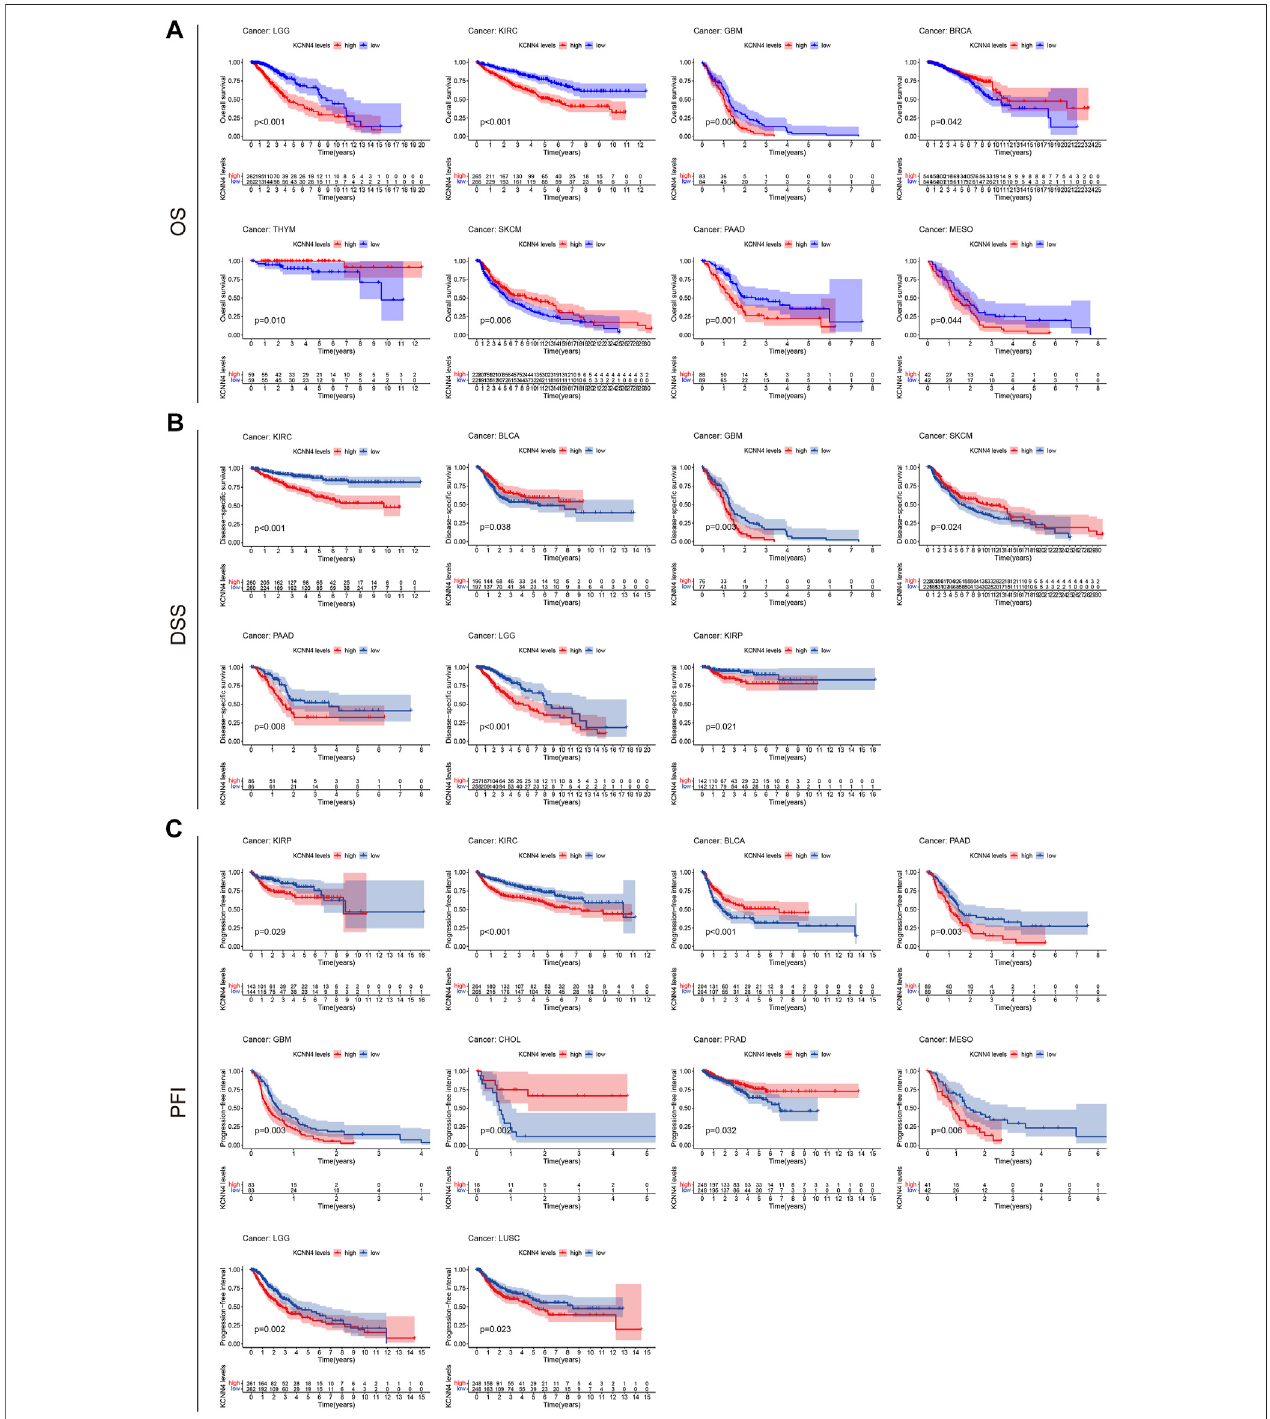
FIGURE 4 | Correlation between KCNN4 expression level and survival indicators as determined through Kaplan – Meier curve analysis. (A) Correlation between KCNN4 expression level and OS as determined through Kaplan – Meier curve analysis. (B) Correlation between KCNN4 expression level and DSS as determined by Kaplan – Meier curve analysis. (C) Correlation between KCNN4 expression level and PFI as determined by Kaplan – Meier curve analysis.